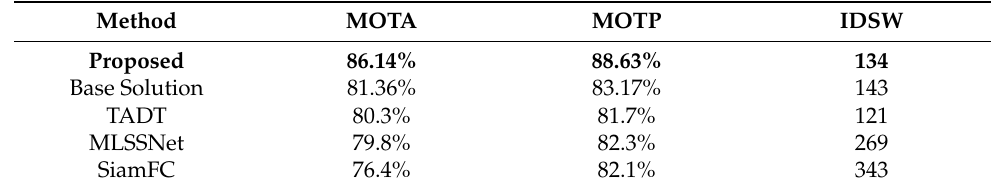
Table 5. Evaluation with respect to different